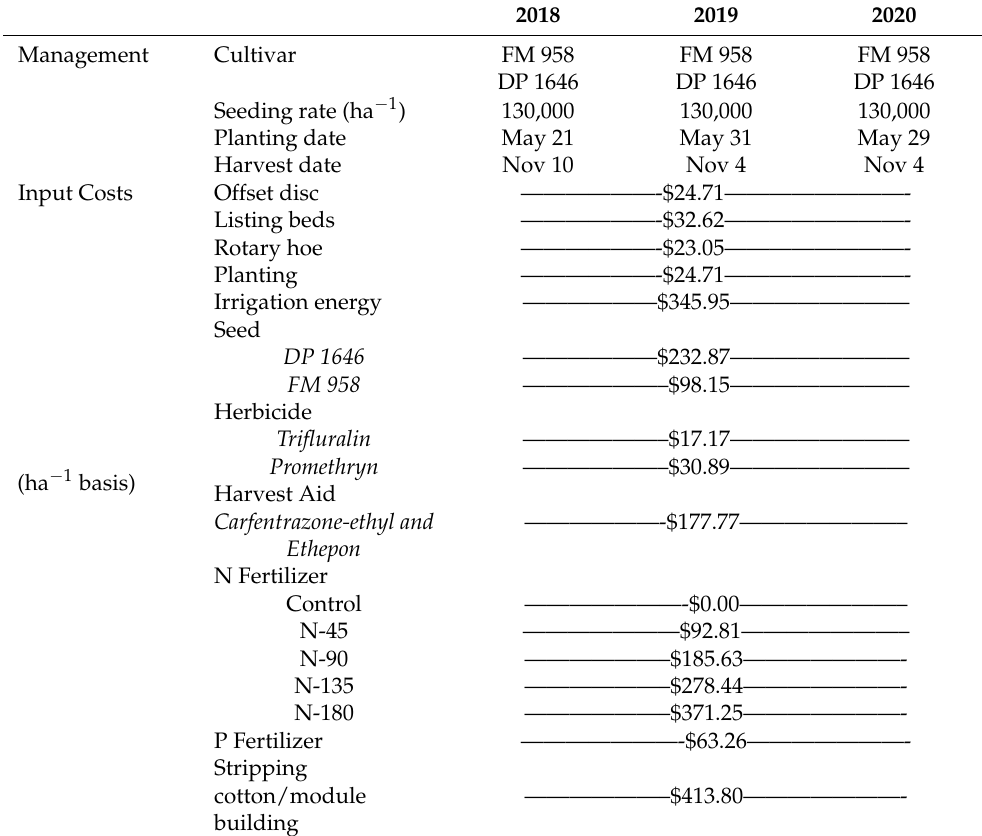
Table 2. Management and input costs of cotton production under five rates of nitrogen (N)